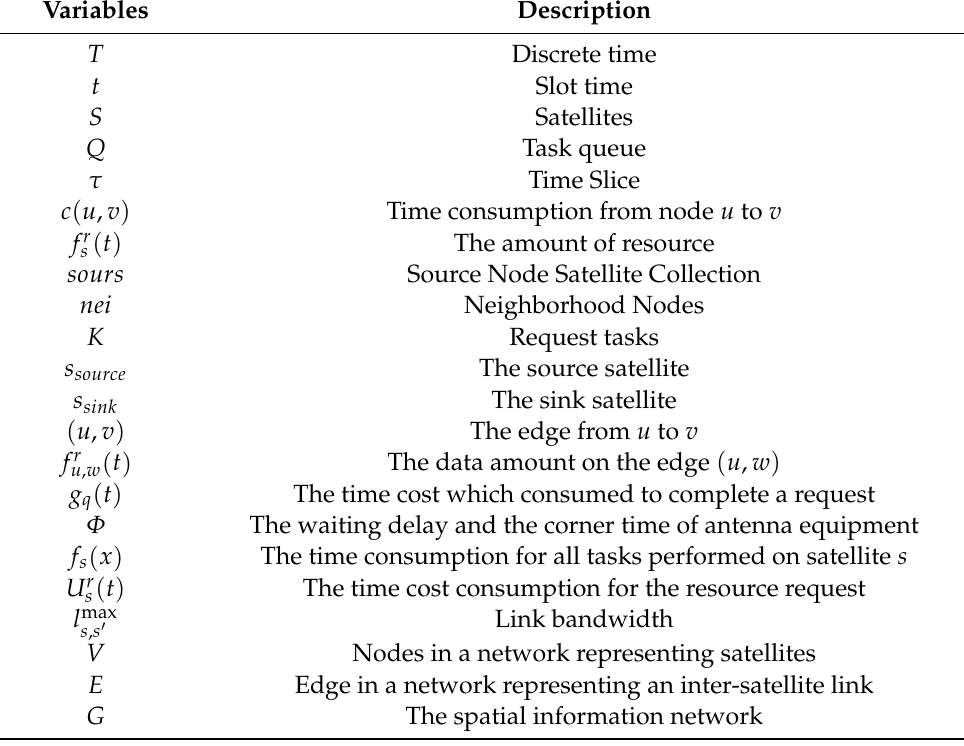
Table 1. List of